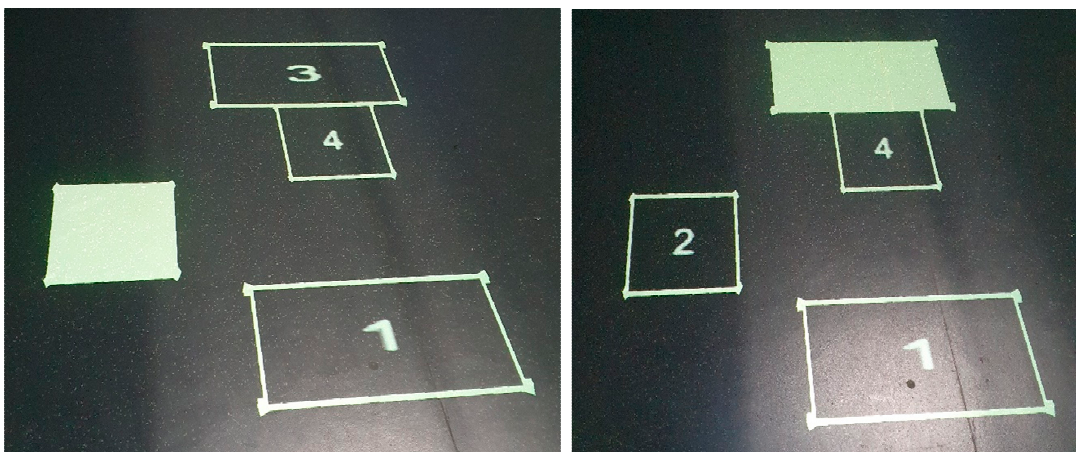
Figure 6. Filled outlines of the objects showing they’re selection by the user in an HMD, selecting object 2 ( left ) and then object 3 ( right ). Highlighted reflection is from skylight.